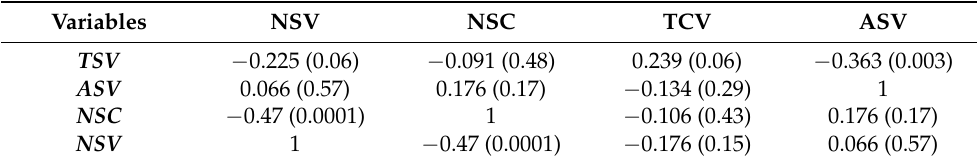
Table 5. Kendall’s correlation results ( τ b (p)) matrix for Stage 3 of the study design. Variables